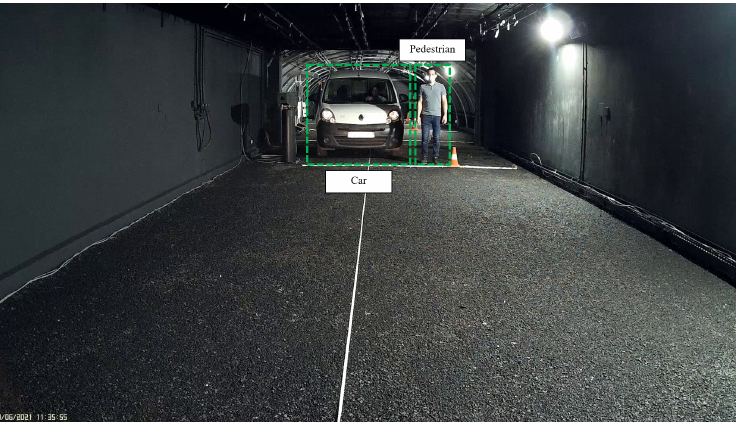
Figure 10. Description of dynamic